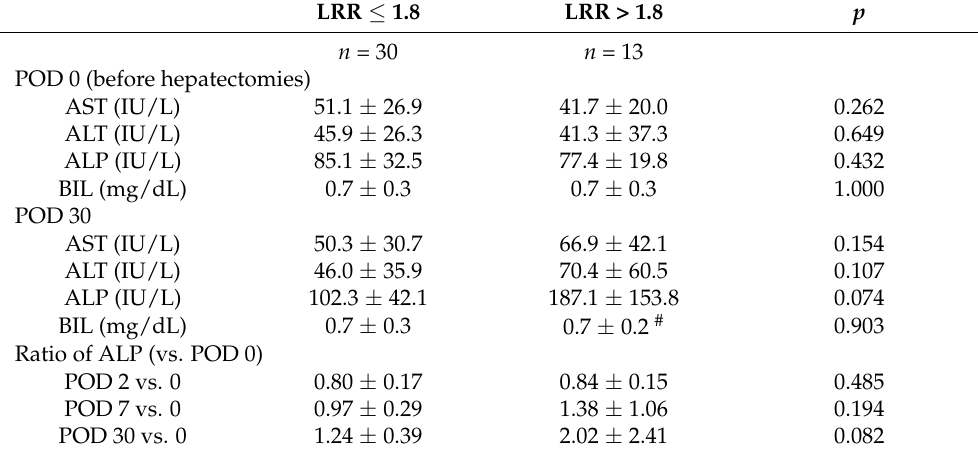
Table 3. Comparison of clinical parameters between lower and higher LRR after hepatectomies. LRR ≤ 1.8